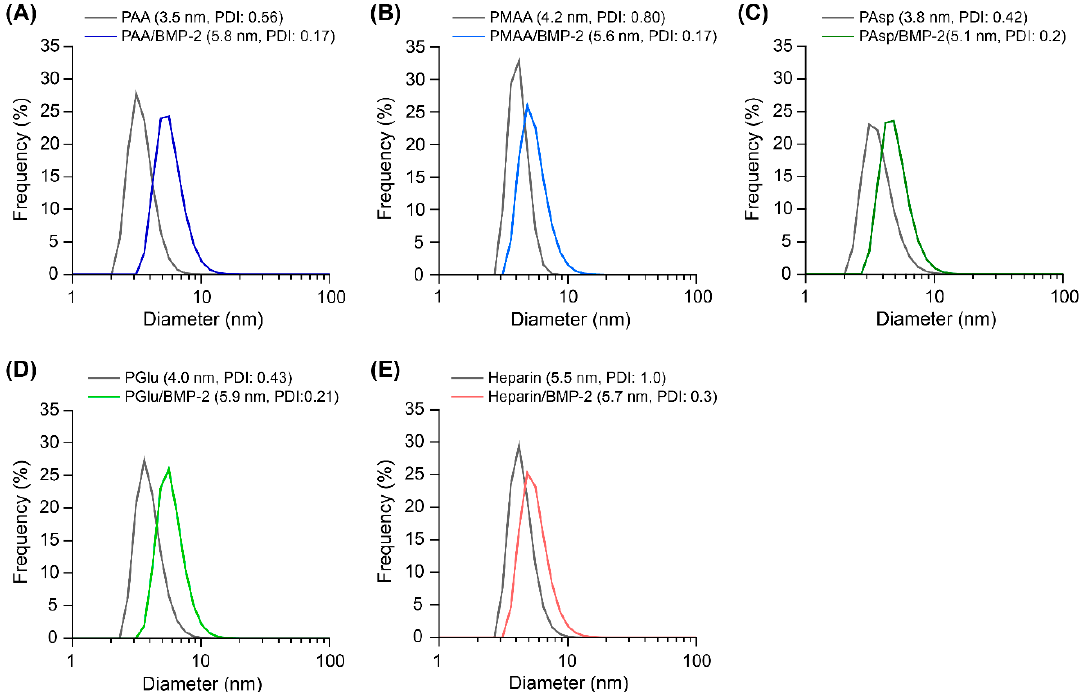
Figure 3. Size distributions of the polymers and their complexes with bone morphogenetic protein 2 (BMP-2): ( A ) PAA and PAA/BMP-2, ( B ) PMAA and PMAA/BMP-2, ( C ) PAsp and PAsp/BMP-2, ( D ) PGlu and PGlu/BMP-2, and ( E ) heparin and heparin/BMP-2 in 10 mM phosphate buffer at pH 7.4. The concentrations of BMP-2 and polymers were 100 μ g/mL and 1 mg/mL, respectively.